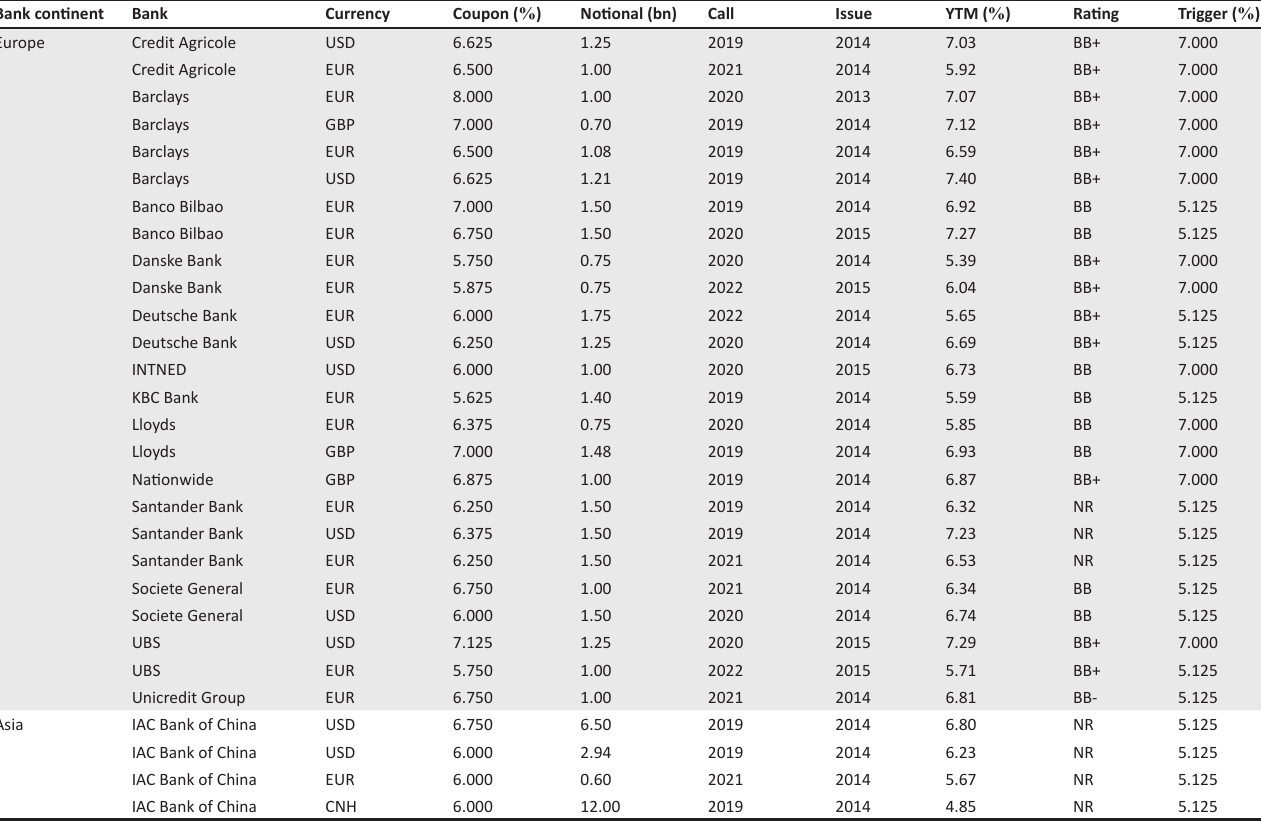
TABLE 3: Contingent convertibles in issuance in Europe and Asia with additional information pertaining to their trigger mechanisms and yields. Bank continent Bank